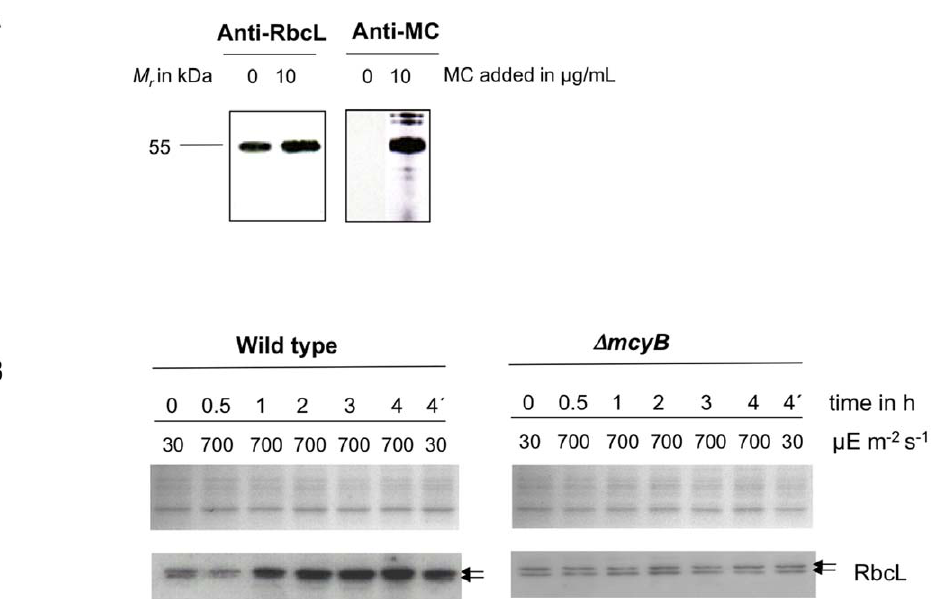
Figure 5. Quantitative analysis of RbcL. A) Immunoblot analysis of in vitro expressed and affinity purified RbcL protein using a RbcL-specific antibody and a microcystin-specific antibody, respectively. Microcystin was added as indicated. B) Representative Coomassie-stained gel pictures (upper panel) and immunoblot analyses (lower panel) with a RbcL-specific antibody of soluble protein extracts of M. aeruginosa PCC 7806 wild type (left) and the D mcyB mutant (right) after high light treatment of 700 m mol photons m 2 2 s 2 1 for up to four hours. The irradiation time of the individual samples is indicated. The sample 4 9 h was irradiated with high light for three hours and subsequently transferred to low light for one hour.